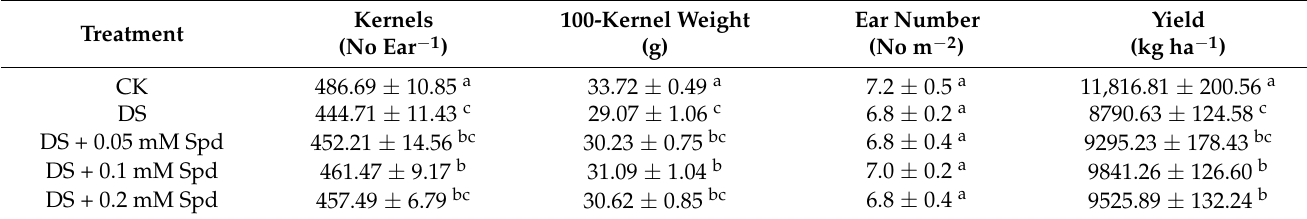
Different letters within the same column indicate significant difference at 5%